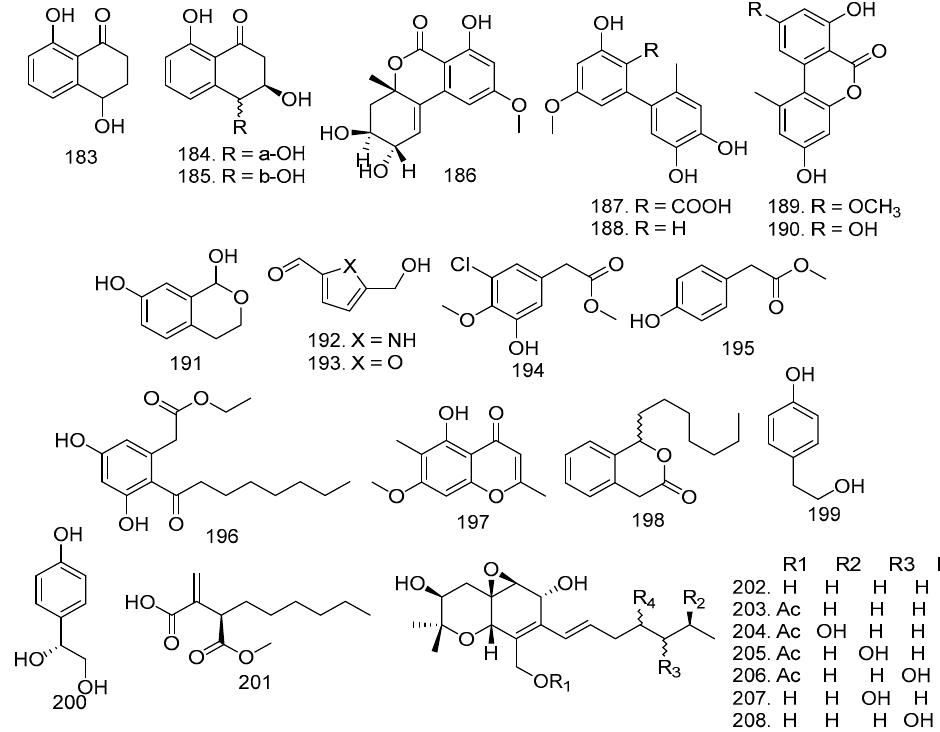
Figure 10. All structures of aromatics ( 183 – 200 ), ester ( 201 ), and quinols ( 202 – 208 ) produced by endophytic fungi from the Meliaceae family.